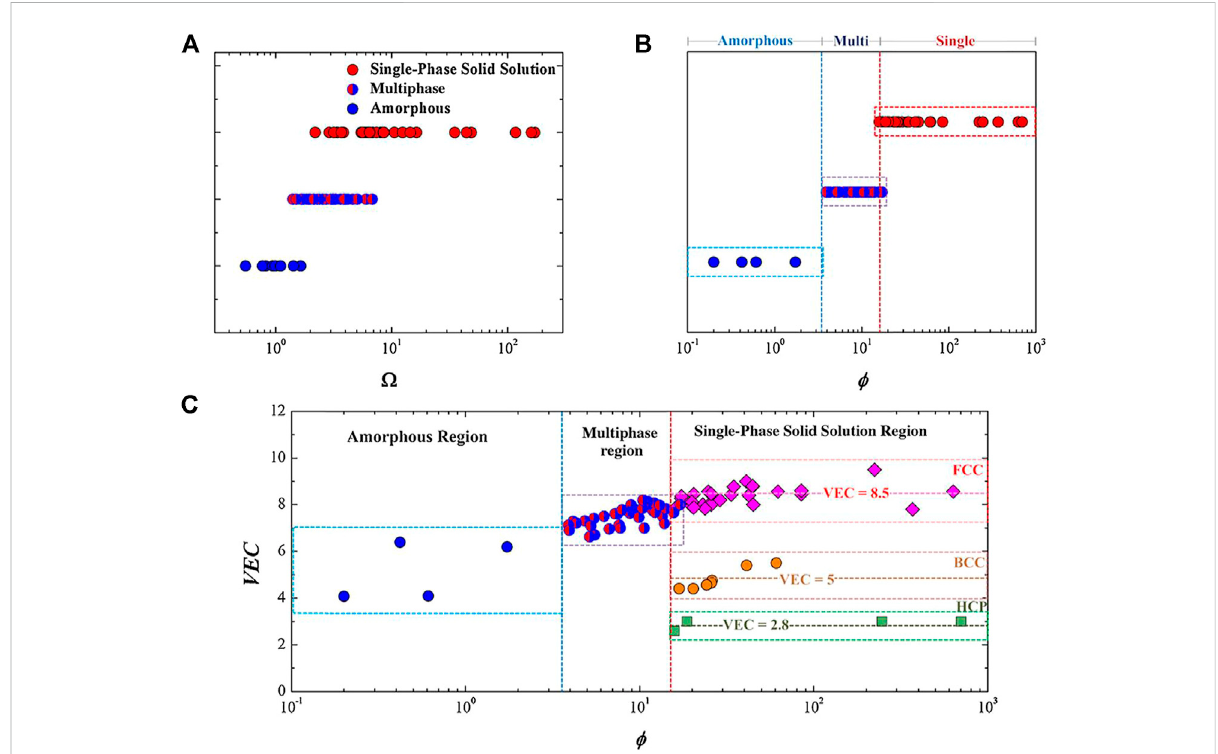
FIGURE 6 Theplotof (A) the Ω valuesversusphasesand (B) the ϕ valuesversusphasesfortheHEAs. (C) TheplotoftheVECversus ϕ fordifferentHEAs.The